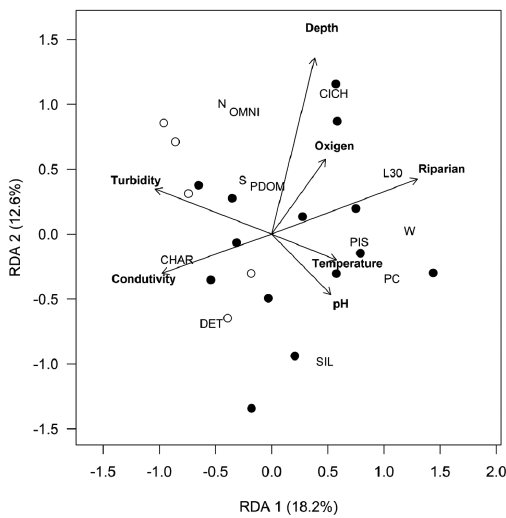
Figure 2. Results of the Redundancy Analysis (RDA) showing the two significant axes (p ≤ 0.05). Black circles: Paineiras reservoir. Open circles: Jorda Flor reservoir. See Table 1 for metrics that correspond to abbreviations.